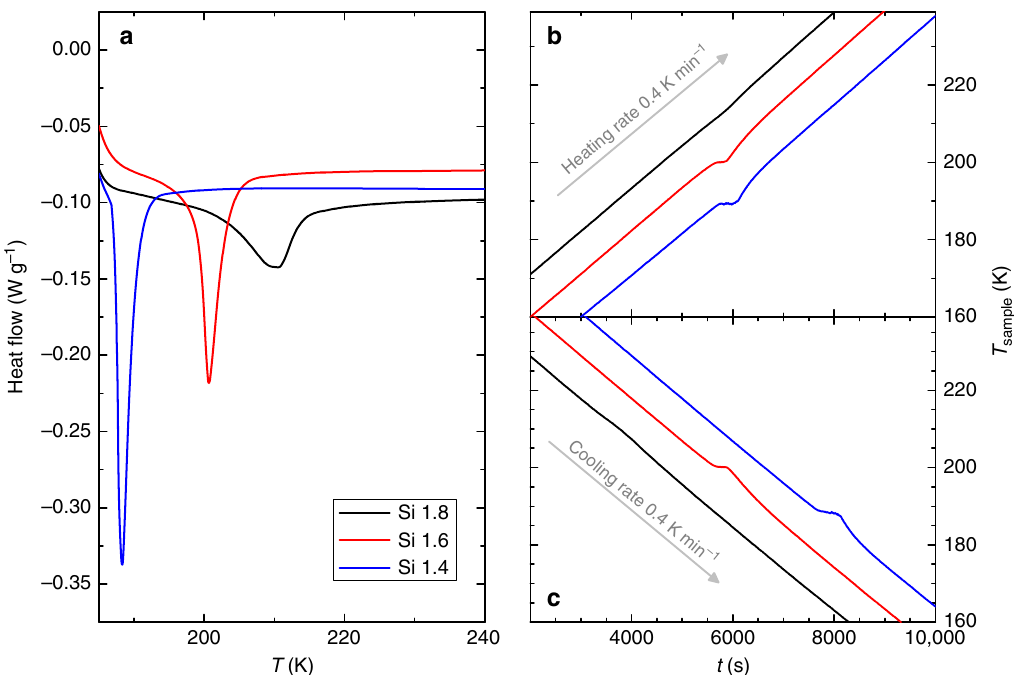
Fig. 1 DSC results and time dependence of sample temperatures. a Temperature dependence of the heat fl ow at a constant heating rate of 10 K min − 1 shows that Si 1.4 and Si 1.6 present FOPT while Si 1.8 undergoes a SOPT; b and c time ( t ) dependence of the sample temperatures, at a constant heating/ cooling rate of sample holder of 0.4 K min − 1 , show a temperature plateau for FOPT samples